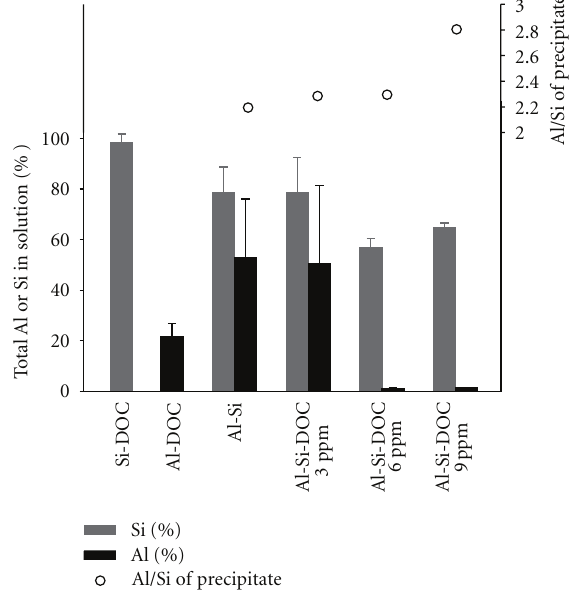
Figure 1: Percentage of total aqueous Al and Si in solution (bars) and Al/Si ratio (open symbols) for binary and ternary solutions with Al = Si = 0 . 3mM and 0–9mg/L